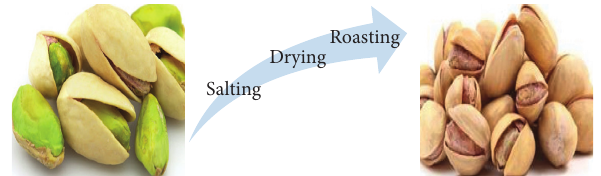
Figure 1: Processing steps and preparation of roasted nuts (unit